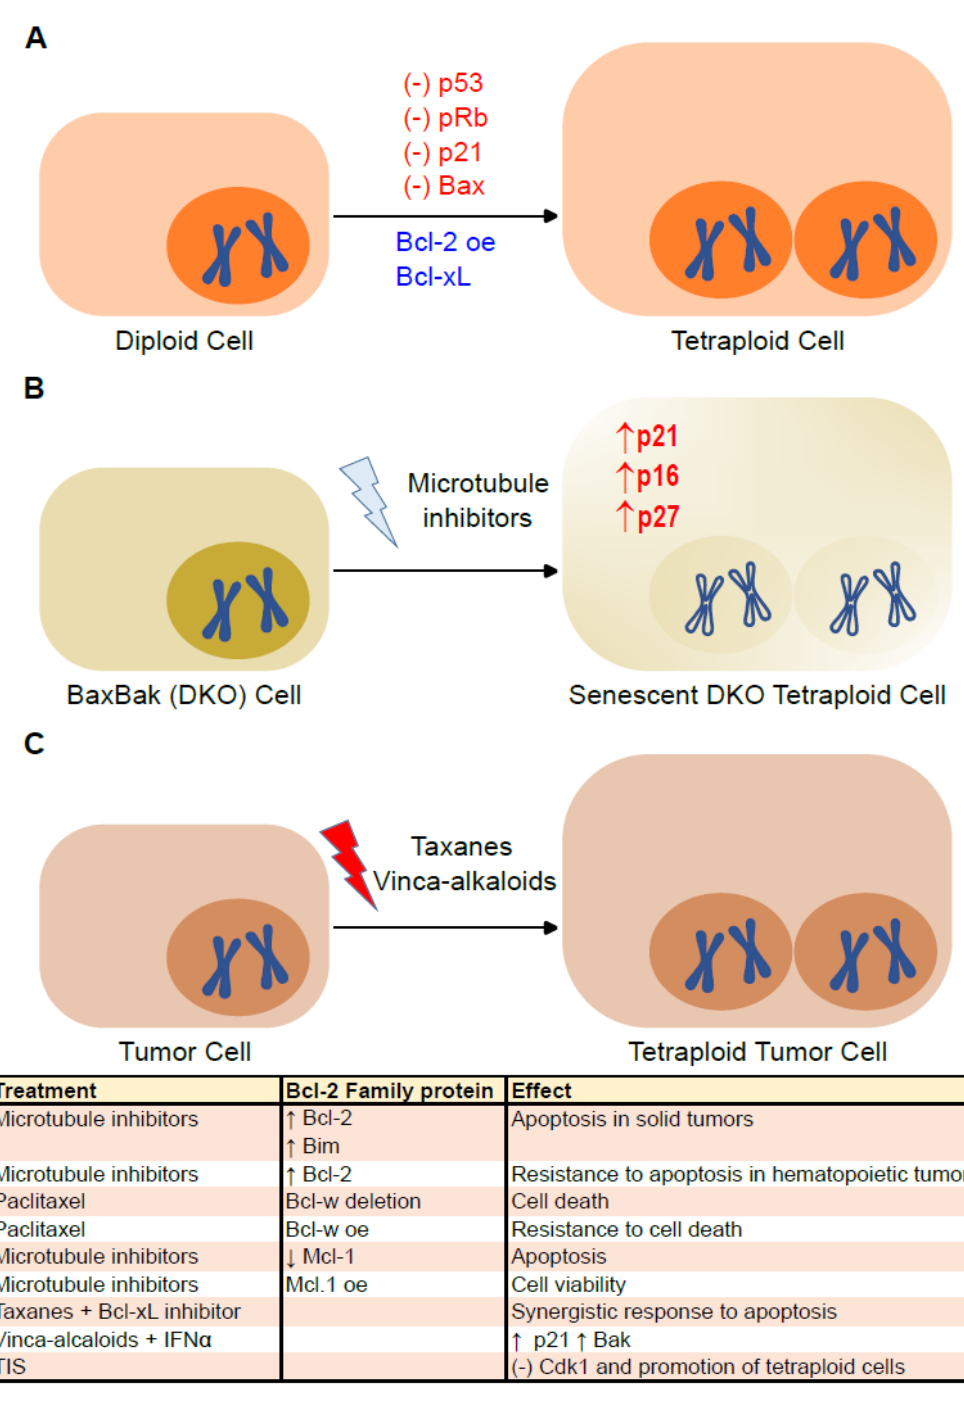
Figure 4. Involvement of Bcl-2 family proteins and senescence in the emergence of tetraploid cells. ( A ) The generation of tetraploid cells is favored by the absence of p53, retinoblastoma protein (pRb), p21 Waf1/Cip1 (p21) and Bax, as well as the overexpression of Bcl-2 and the presence of Bcl-xL. ( B ) Cells deficient in Bax and Bak enter senescence when tetraploidized with microtubule inhibitors and show an increase in p21 Waf1/Cip1 , p16 INK4a (p16) and p27 Kip1 (p27). ( C ) Some chemotherapies, such as taxanes and vinca alkaloids, induce tumor cell polyploidization and cell cycle arrest. The table sum- marizes the relationship found between tetra- or polyploidy-inducing chemotherapies, Bcl-2 family proteins and their effects on tumor cells. Up arrows mean increase, down arrows mean decrease.